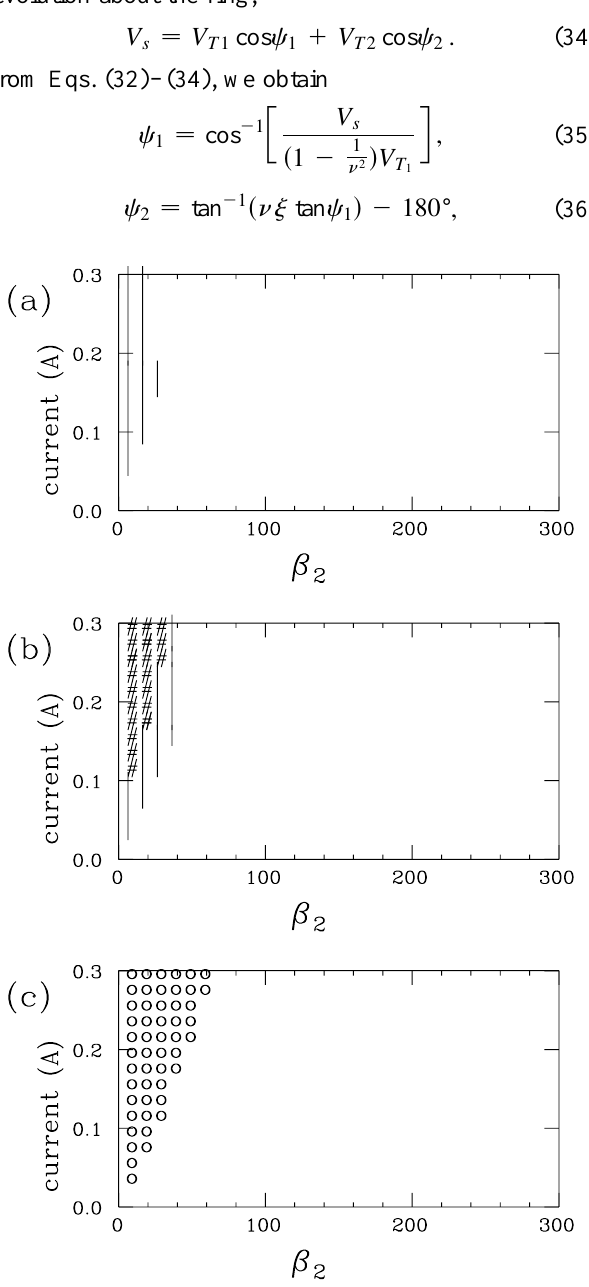
FIG. 8. (a) Robinson instabilities are predicted without con- sideration of mode coupling, for active Landau-cavity opera- tion with optimally lengthened bunches in the Aladdin lattice with a fundamental rf voltage of 90 kV. A symbol is plotted when Robinson instability is predicted for a given ring current and effective rf coupling of the Landau cavity ( b 2 ). Vertical line: dipole instability. (b) Dipole-quadrupole mode coupling is included in Robinson instability predictions. Vertical line: coupled-dipole instability; #: fast mode-coupling instability. (c) Instabilities observed in 500 000 turn simulations. When the relative energy spread at the end of a simulation exceeds the natural value (cid:3) 4.8 3 10 2 4 (cid:4) by $ 10% , a circle is plotted to sig- nify instability.